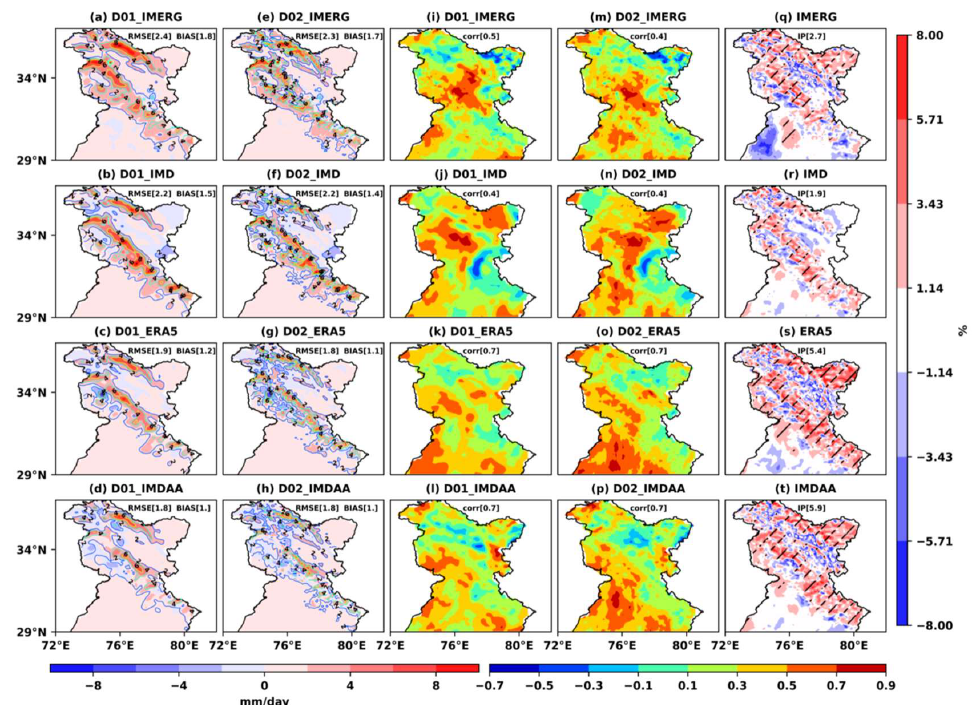
Figure 4. Seasonal precipitation difference (BIAS) between model and observations: ( a ) D01-IMERG, ( b ) D01-IMD, ( c ) D01-ERA5, ( d ) D01-IMDAA, ( e ) D02-IMERG, ( f ) D02-IMD, ( g ) D02-ERA5, and ( h ) D02-IMDAA, shading and contours represent the BIAS and RMSE, respectively. Seasonal precipitation correlation between model and observations: ( i ) D01-IMERG, ( j ) D01-IMD, ( k ) D01-ERA5, ( l ) D01-IMDAA, ( m ) D02-IMERG, ( n ) D02-IMD, ( o ) D02-ERA5, and ( p ) D02-IMDAA, shading and contours represent the BIAS and RMSE, respectively. Forecast impact parameter for model-simulated seasonal precipitation against ( q ) IMERG, ( r ) IMD, ( s ) ERA5 and ( t ) IMDAA for the period 2001–2016.